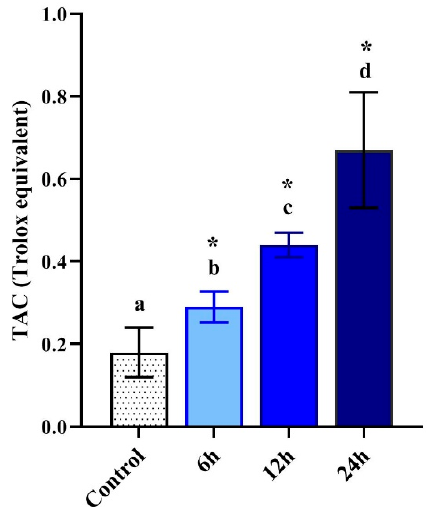
Figure 5. The total antioxidant capacity (TAC) in control and injected M. domestica larval hemolymph at 6, 12 and 24 h post-injection with LPS. Different letters indicate significant difference ( p < 0.05). * indicate high significance with respect to control ( p < 0.01). Data were expressed as mean ± SD. The experiments were done in triplicate ( n = 3).